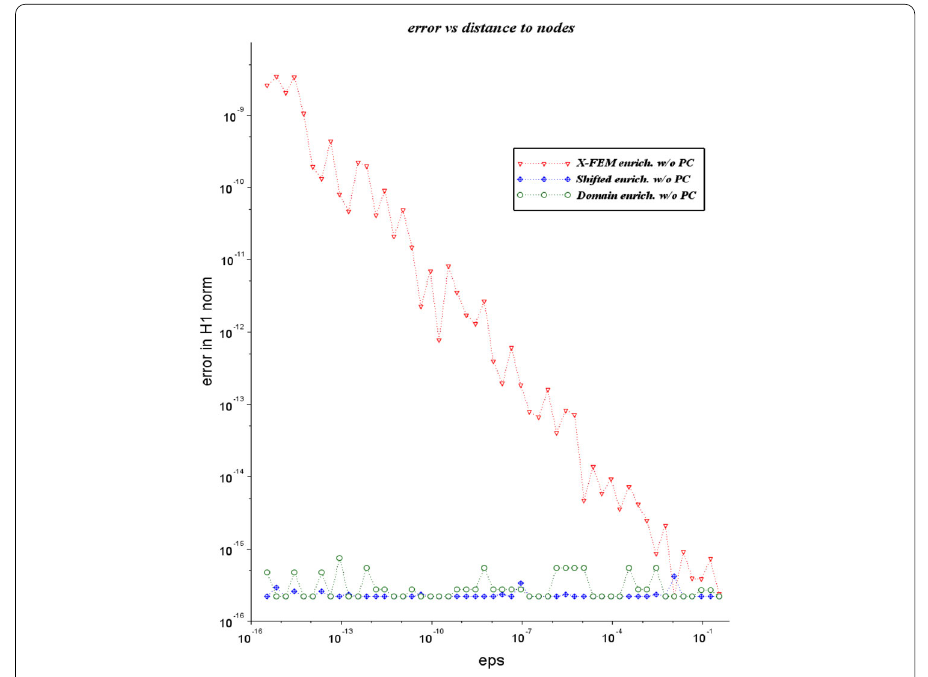
Fig. 9 H1-error of strongly discontinuous approximations with linear elements. Shifted and domain enrichments outperform X-FEM formulation when “eps” ( ε ) goes to zero